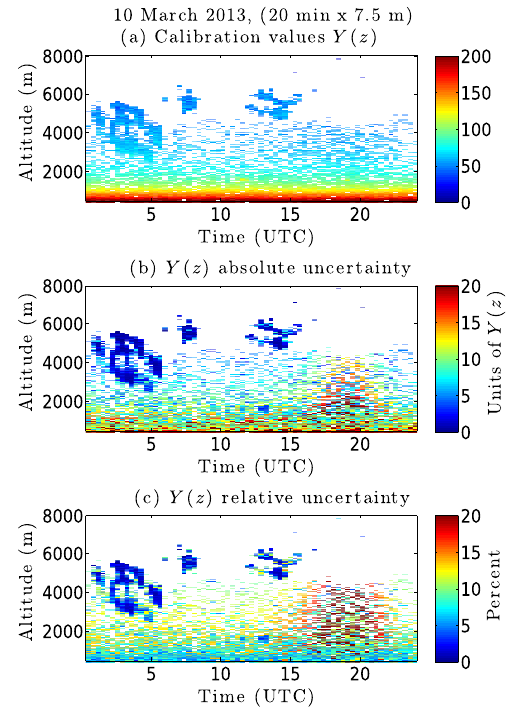
Figure 4. (a) The Y(z) calibration values from 10 March 2013 indi- vidually for each data point. (b, c) Absolute and relative uncertain- ties, respectively, in the calculated individual values of Y(z) .